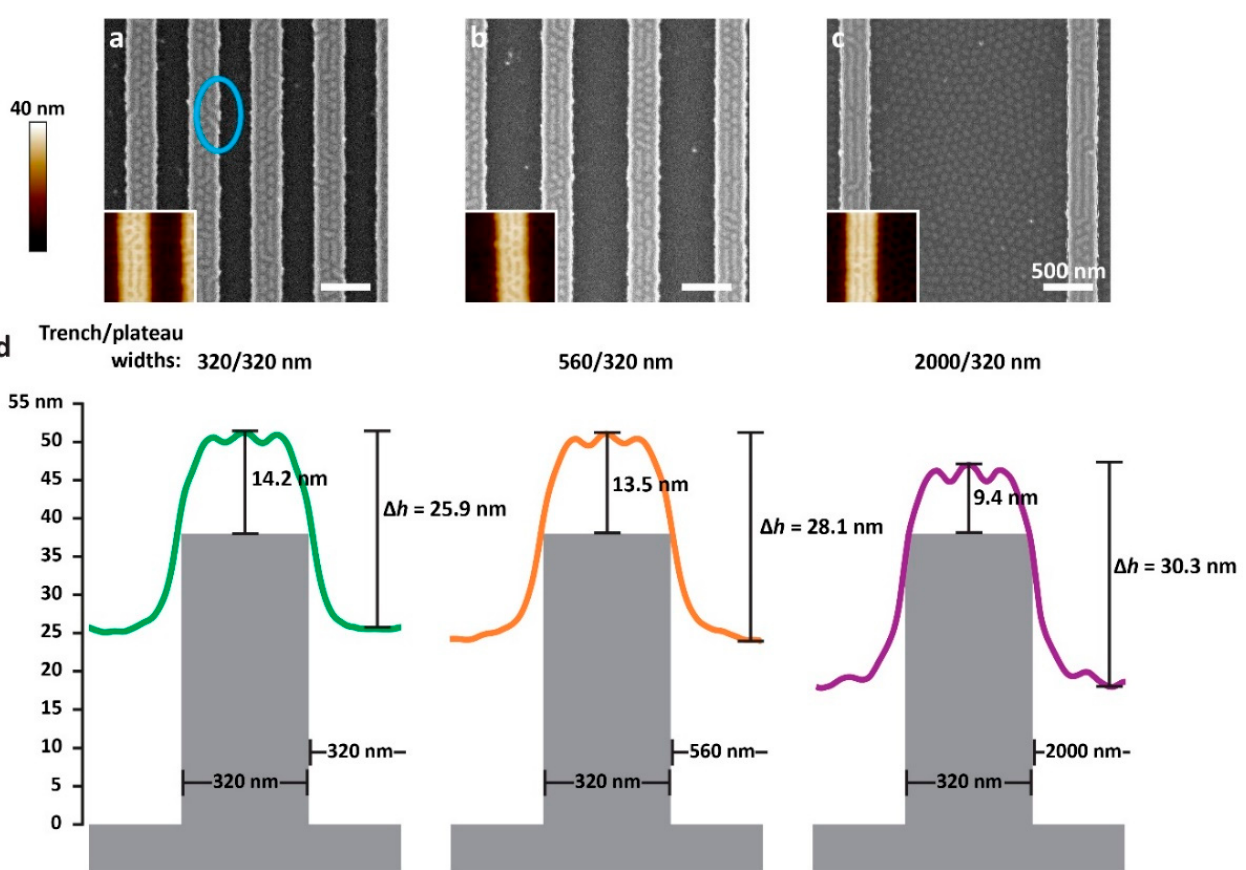
Figure 3. SEM images of samples of 18 nm-thick films cast over substrates with 38 nm-deep trenches and lateral trench/plateau widths of: ( a ) 320/320 nm, ( b ) 560/320 nm, and ( c ) 2000/320 nm. All scale bars represent 500 nm. Insets in panels a-c show SFM height images of the corresponding sample (identical magnification as the SEM images). Blue ellipse indicates defects in the stripe at the right-hand edge of the plateau. ( d ) An illustration showing the experimental height cross-section corresponding to each of the SEM images overlaid on schematics of the substrate topography. The height of the film over the plateau was established according to local film measurements for these samples.